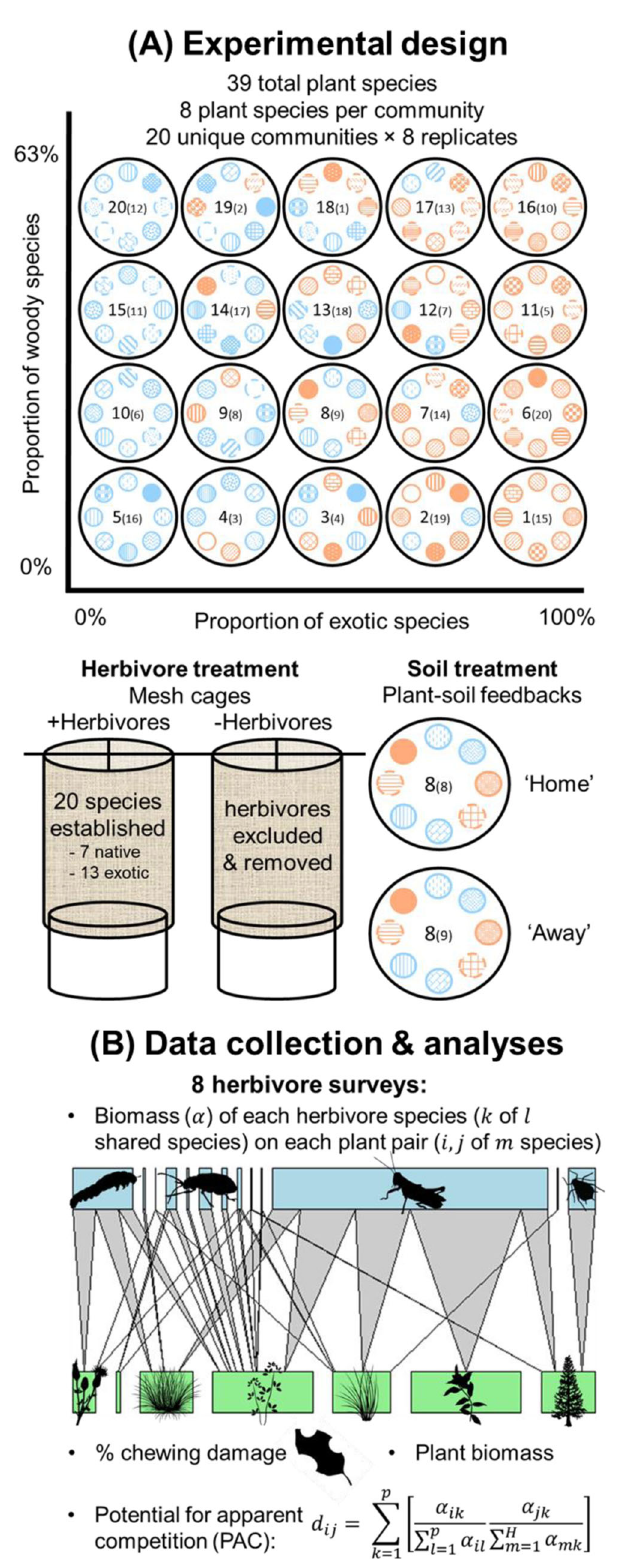
Fig. 5 Conceptual fi gure detailing the experimental design, data collection and analyses. The upper portion of the fi gure shows the experimental design ( A ), with orthogonal exotic and woody gradients of the 20 unique plant communities (numbered, with the community used for the ‘ away ’ soil treatment in parentheses), where plant provenance, functional group and plant species are represented by symbol colour (blue = native plant species, orange = exotic plant species), outline (solid = herbaceous, dashed = woody), and pattern (key in Supplementary Table 24), respectively. Also shown are details of the herbivore (mesh cages with herbivore addition and exclusion) and soil (plant – soil feedback; ‘ home ’ = soil from conspeci fi cs and ‘ away ’ = soil from heterospeci fi cs) treatments; The lower portion of the fi gure details the data collected for analyses ( B ), including plant and herbivore biomass, herbivore diversity, herbivore chewing and scraping damage, and the equation for pairwise potential for apparent competition 86 . Symbols courtesy of the Integration and Application Network